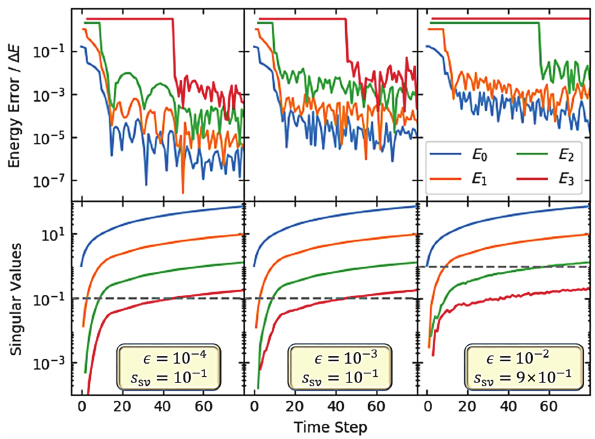
FIG. 2. Relative error and corresponding singular values of the overlap matrix for a Hamiltonian of linear spectrum with different noise values. Upper panels: relative error of the first four eigenvalues from the VQPE secular equation for a Hamil- tonian of linear spectrum E N = N (cid:10) E ( (cid:10) E = 0.75 here) and perfect time step (cid:10) t P , including Gaussian noise N ( 0, (cid:11)) to the Hamiltonian and overlap matrix elements. We choose the sin- gular value truncation threshold s SV to be at least 2 orders of magnitude larger than the noise standard deviation (cid:11) . The ref- (cid:11) erence state follows | (cid:4) 0 (cid:3) ∝ e − E N | N (cid:3) , the effective support N space size determined using the singular value truncation thresh- = − ln ( s )/( 2 (cid:10) E ) − 1. Lower panels: corresponding old N max SV SVD singular values of the overlap matrix as a function of time. The horizontal dashed line represents the threshold s SV . Note that, until a given singular value is larger than s SV , we cannot extract the corresponding eigenvalue from the generalized eigenvalue problem. This is represented by the horizontal lines in the upper panels. See the text for details.